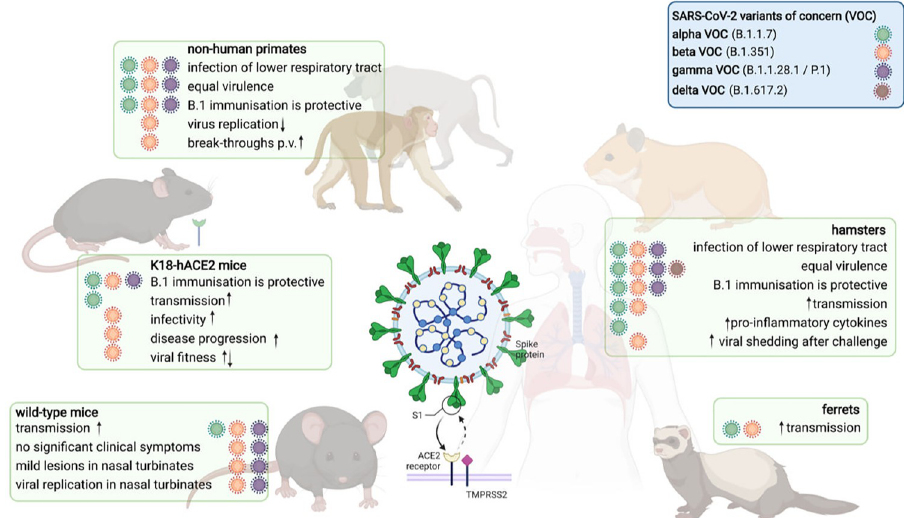
Fig 1. SARS-CoV-2 VOC in animal models. The schematic summarizes findings related with virulence, transmission, and cross-protection gathered in the indicated animal models so far. Figure created with Biorender (Biorender.com). huACE2 AU : AbbreviationlistshavebeencompiledforthoseusedinFigs 1 and 2 : Pleaseverifythatallentriesarecorrect : , human angiotensin I-converting enzyme 2; K18, cytokeratin-18; SARS-CoV-2, Severe Acute Respiratory Syndrome Coronavirus 2; VOC, variant of concern.